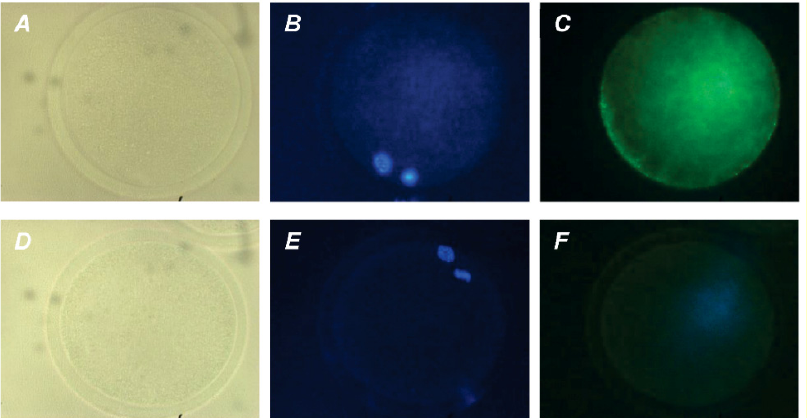
Figure 4. Immunofluorescent detection of PRL receptors in M-II oocytes after the 20 h maturation of bovine CEOs. ( A , D ) Bright-field images. ( B , E ) DNA staining with DAPI (blue). ( C ) Positive staining using the MA1-610 antibody and goat anti-mouse IgG conjugated with Alexa Fluor 488 (green). ( F ) Negative control performed by omitting the primary antibody. Original magnification: ×400.